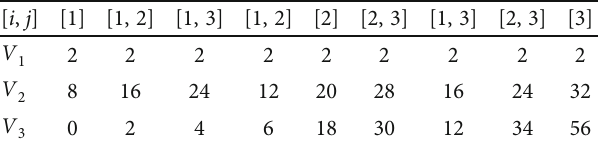
- II ½ i, j (cid:2) for all i , j ≥ 2 . 4